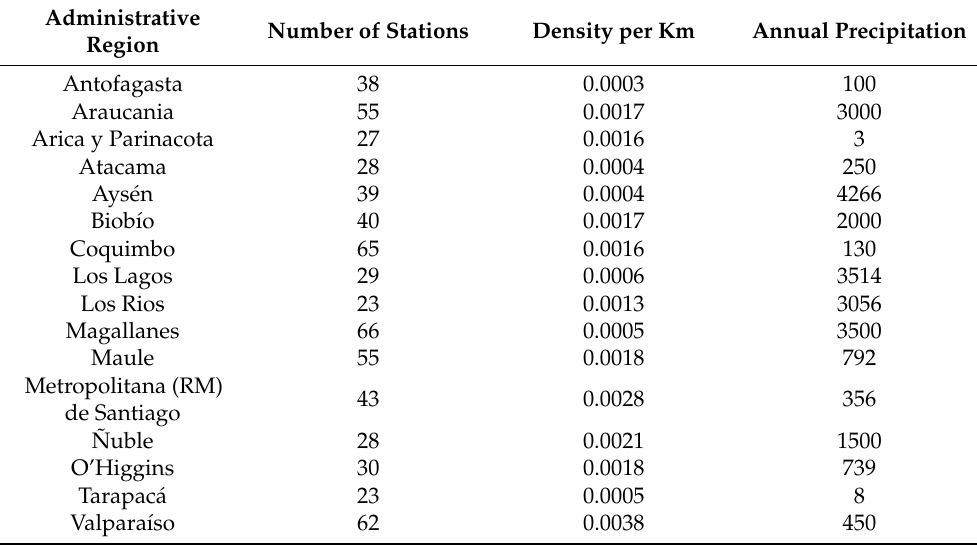
Table 1. Administrative regions and their rain gauge